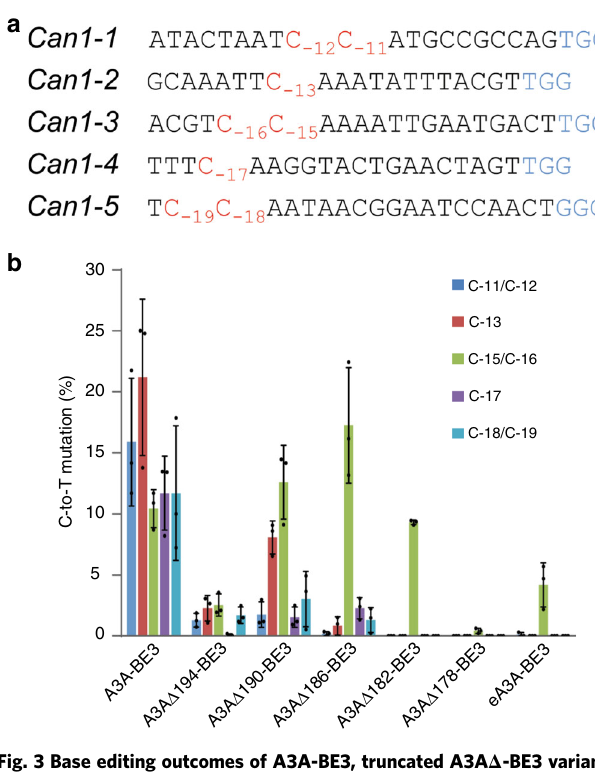
Fig. 3 Base editing outcomes of A3A-BE3, truncated A3A Δ -BE3 variants and the recently optimized editor eA3A-BE3 (ref. 22 ) when targeting speci fi c sites in the yeast Can1 gene. a Sequences of the fi ve target sites (containing Cs at different positions). Target Cs are indicated in red and numbered relative to the PAM (blue). Edited clones were identi fi ed by using the canavanine selection strategy (see “ Methods ” section). b Base editing ef fi ciency and precision. The x -axis represents the target Cs within the protospacers. The y -axis shows their C-to-T mutation frequency (see “ Methods ” section). Values and error bars represent the mean and standard deviation of three independent biological replicates. Source data underlying b are provided as a Source Data fi